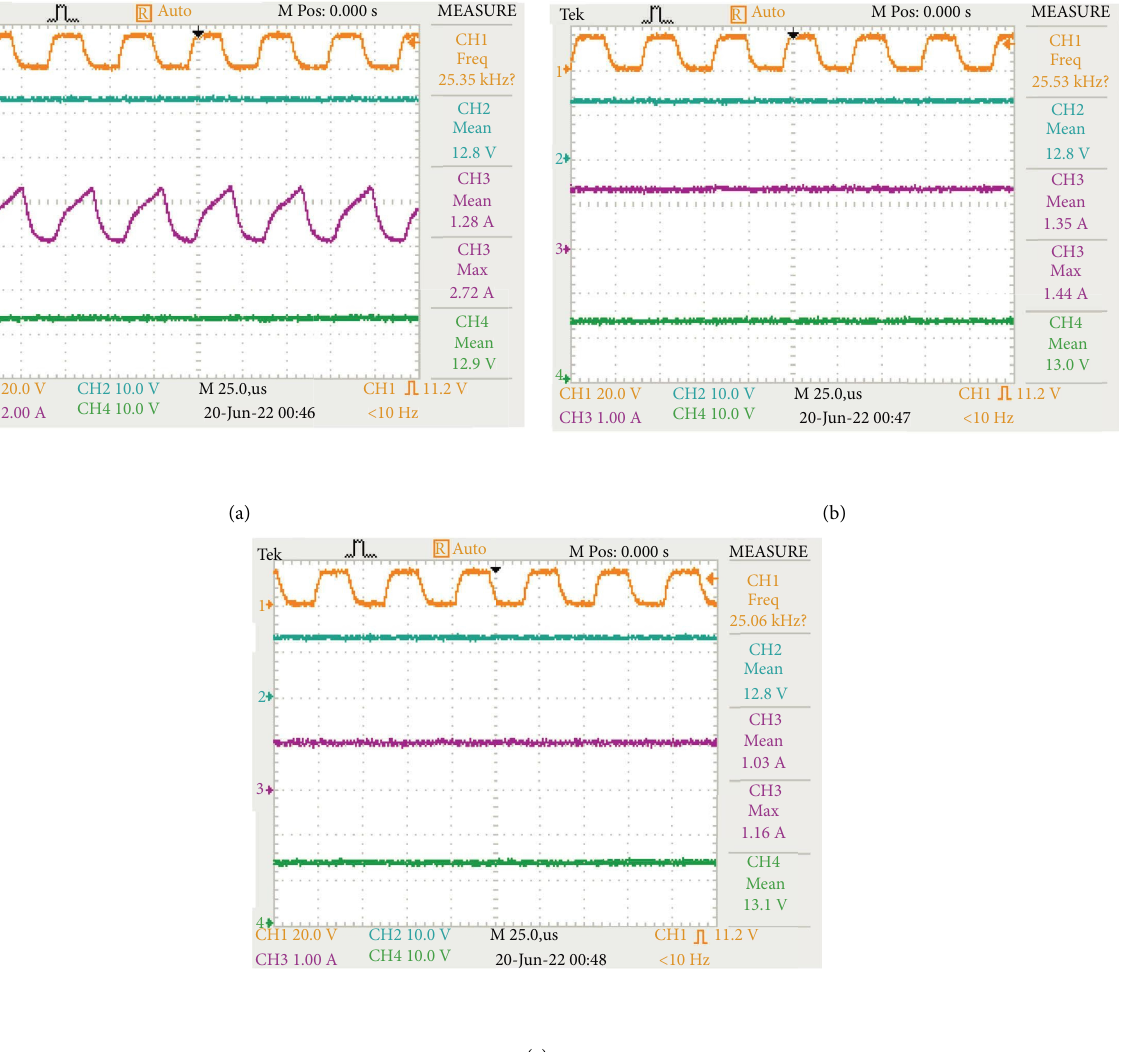
Figure 18: (a) PWM, V in , I L 1 , and V o ; (b) PWM, V in , I in , and V o (c) PWM, V in , I o , and V o Cuk converter with Pi